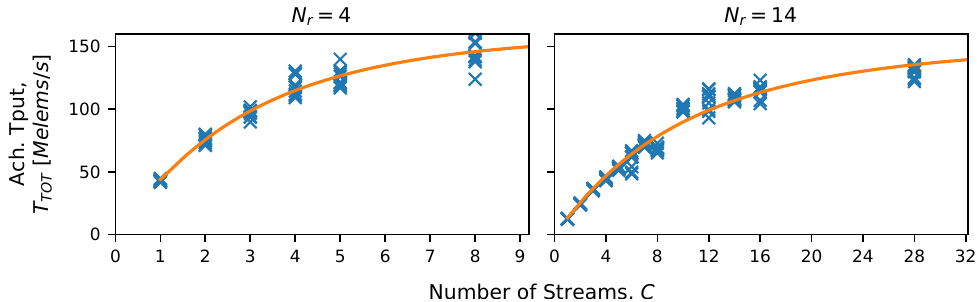
Figure A2. Calibrated total achievable throughput plot of the virtualized AES encryption cipher application. The parameters used are N = C and S = 0 (i.e., no secondary memory). Data points are from 10 tool flow runs.